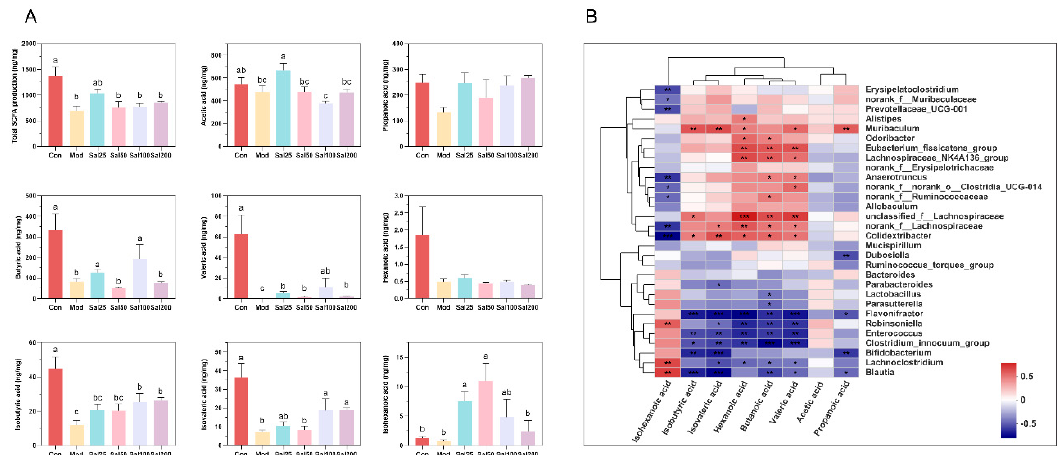
Figure 7. The effects of salidroside on short-chain fatty acid (SCFA) production. ( A ) The contents of SCFAs. The values are displayed as the mean ± SEM. Small letters show significant differences between groups ( p < 0.05). ( B ) Heatmap of correlation analysis between gut microbiota and SCFAs (* p < 0.05, ** p < 0.01, *** p < 0.001).